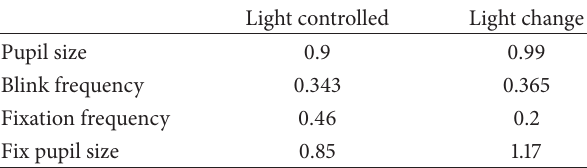
Table 3: The influence coefficients of four